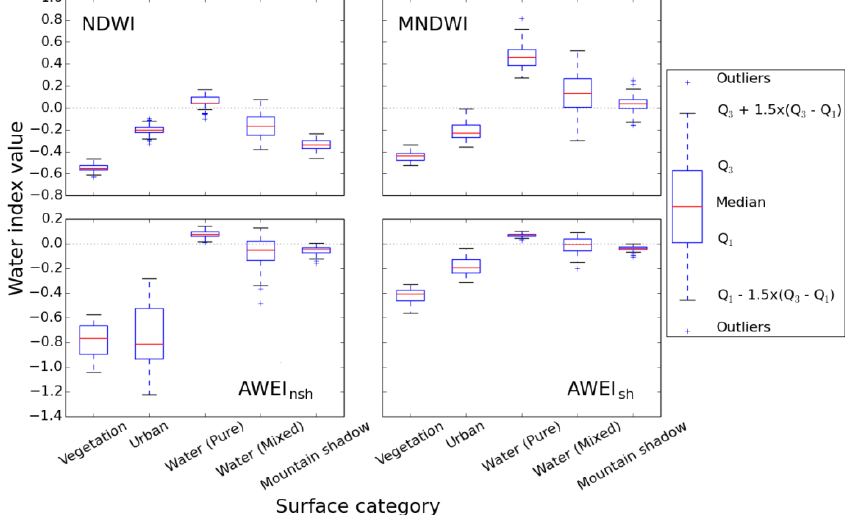
Figure 3. Water index (WI) value distributions for mixed water, pure water, vegetation, urban and mountain shadow surface categories. In the box and whisker plots, the second, third and fourth horizontal lines from the bottom represent the first quartile (Q and third quartile (Q ), respectively. The bottom and top lines from the bottom 3